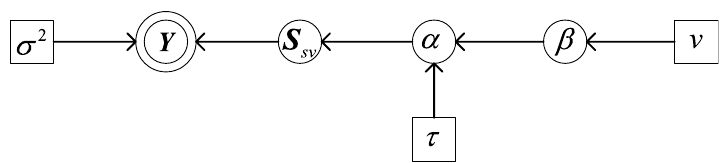
Fig. 3 Block diagram of variational Bayesian